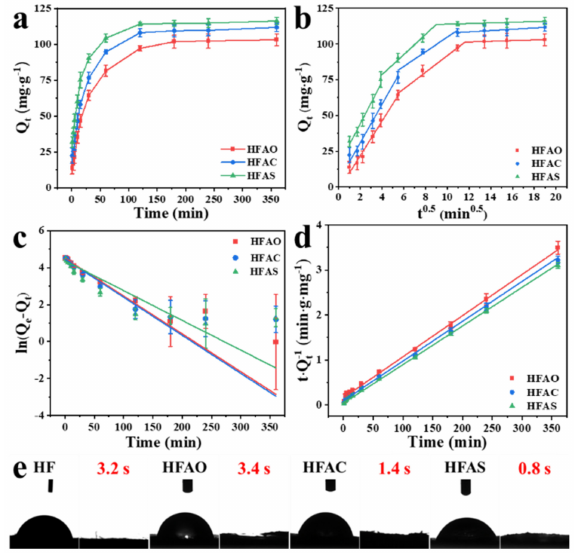
Figure 3. Contact time ( a ) and kinetics study on HFAO, HFAC, and HFAS; W-M ( b ), pseudo-1st-order ( c ), and pseudo-2nd-order ( d ) models linearly fitted curves at pH 8.3; water contact angle and total permeant time of HF-based adsorbents ( e